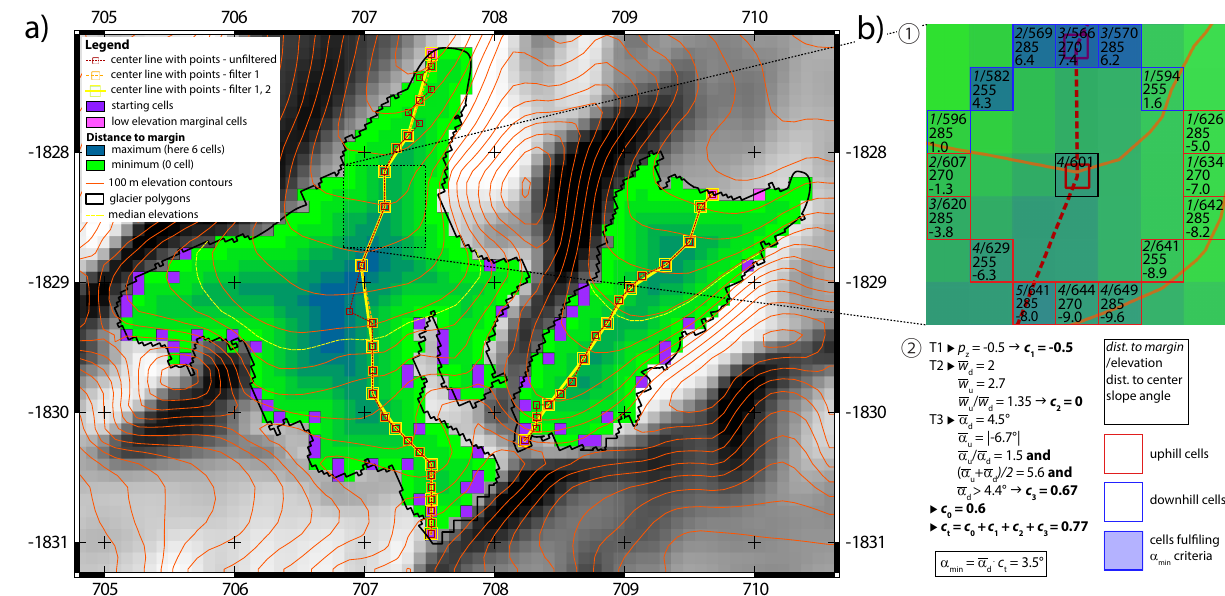
Figure 2. Concept of the calculation of center lines visualized on the example of two small mountain glaciers of East Greenland. T1, T2 and T3 refer to the three trade-off functions. Note that all calculations are carried out in radians but for the ease of understanding angles are shown in degrees. Coordinates are in kilometers, with polar stereographic projection (EPSG